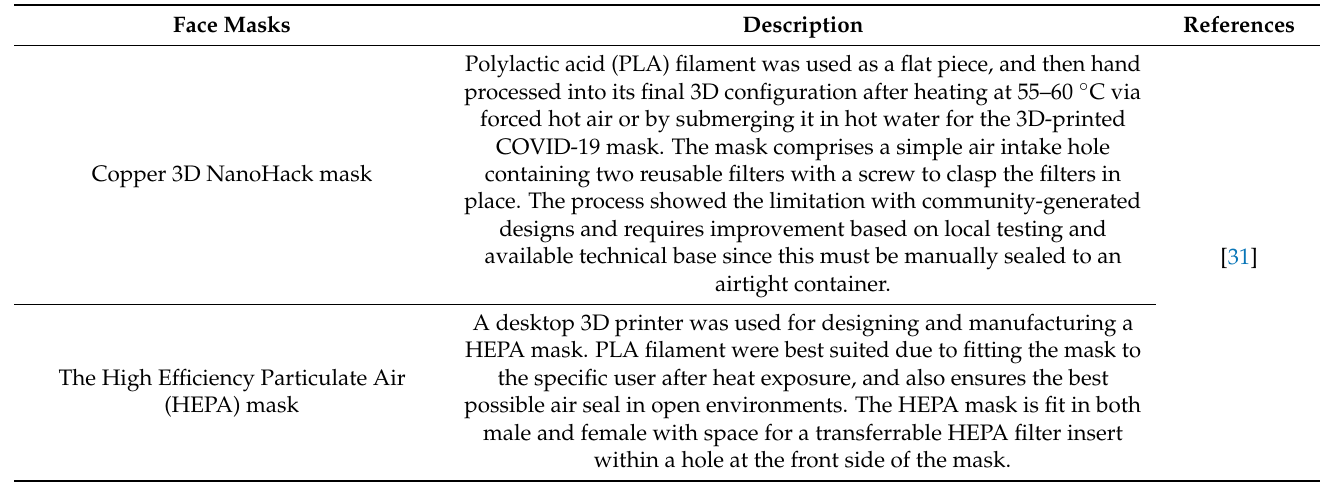
Table 1. Masks and other personal protective equipment (PPE) kits devised by using 3D printing technology for protection from